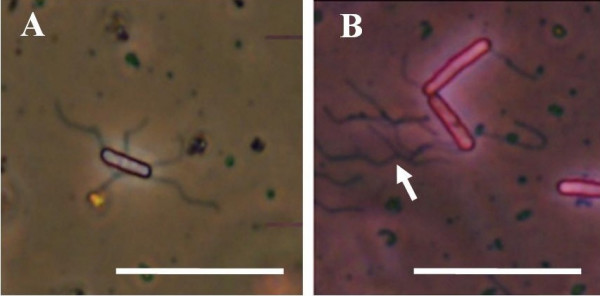
Flagella filaments. Visualization of cell flagella extracted from the leading colony edges grown on swarming plates. (A) Typical swarming cell from the JMG1655 ΔrecA (pRecA-Htg) strain. (B) Typical swarming cells from the JMG1655 ΔrecA (pCA24N) strain. The arrow indicates the position of the flagella in the preparation. Bar 10 μm.